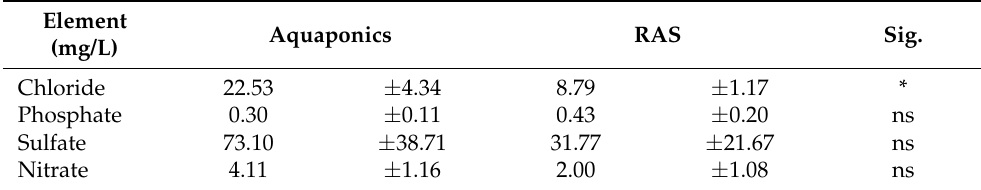
Table 5. Concentrations of chloride Cl − , nitrate-N NO 3 -N, sulfate SO 42 − , and phosphate PO 43 − (mg/L) in water samples taken on the last day (day 42) of the experiment in aquaponics and RAS from fish tanks. For aquaponics treatment spinach ( Spinacia oleracea ) was grown in a coupled aquaponics system together with rainbow trout ( Oncorhynchus mykiss ).